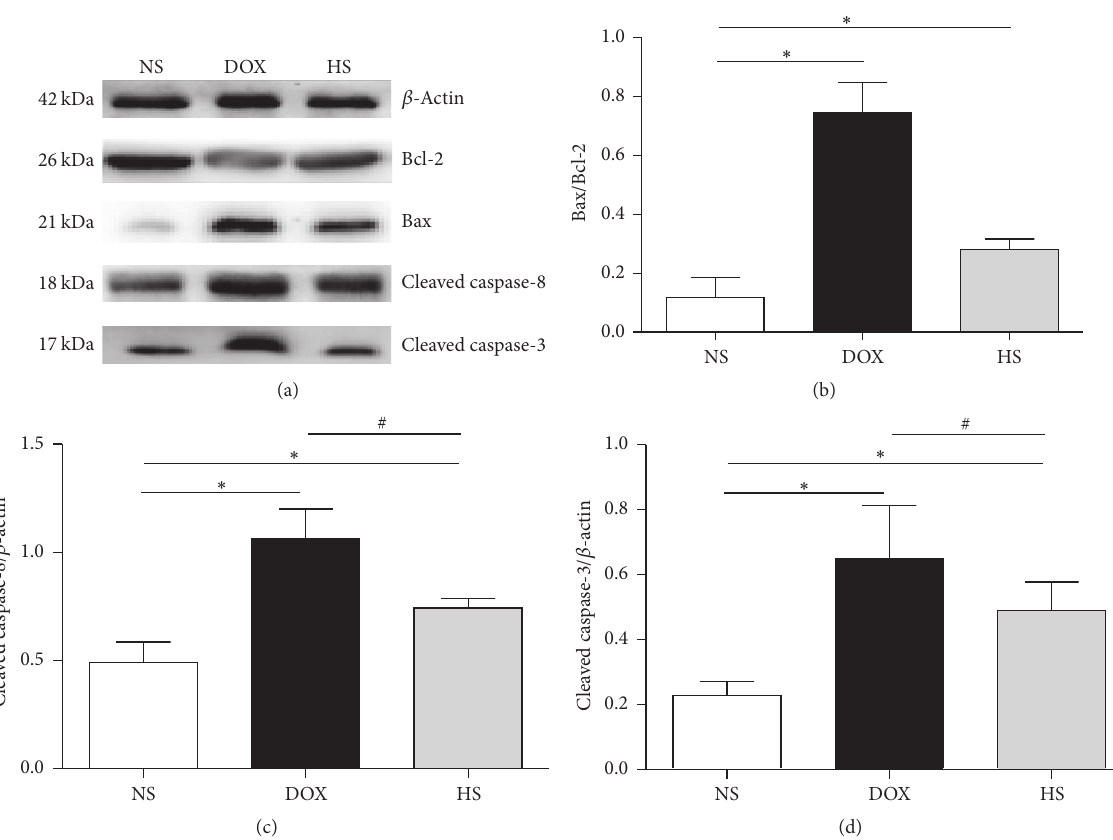
Figure 7: The antiapoptosis effect of hydrogen-rich saline on cardiac tissue. Representative expression of apoptosis-related proteins in the heart of three groups was detected (a–d). Data are shown as mean ± SD, 𝑛 ≥ 3 . ∗ 𝑃 < 0.05 versus NS group; # 𝑃 < 0.05 versus DOX group.